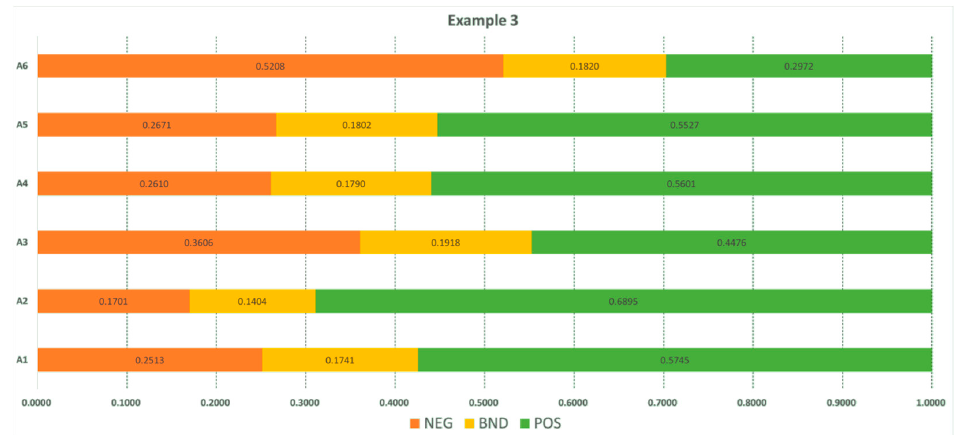
Figure 2. Results of the multi-attribute three-way decisions for Example 3.